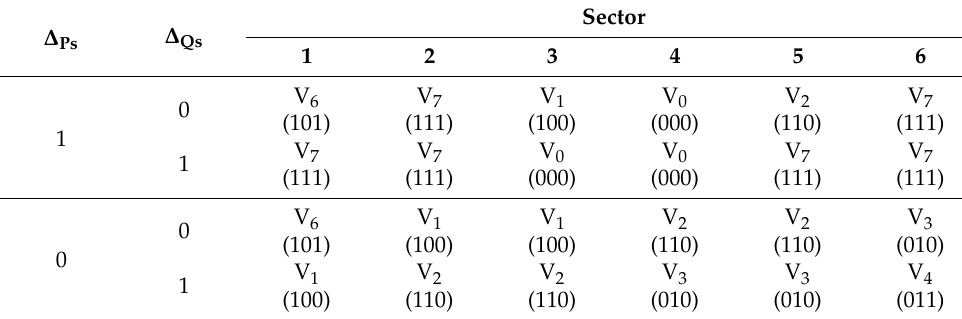
Table 1. Switching tables of DPC based hysteresis